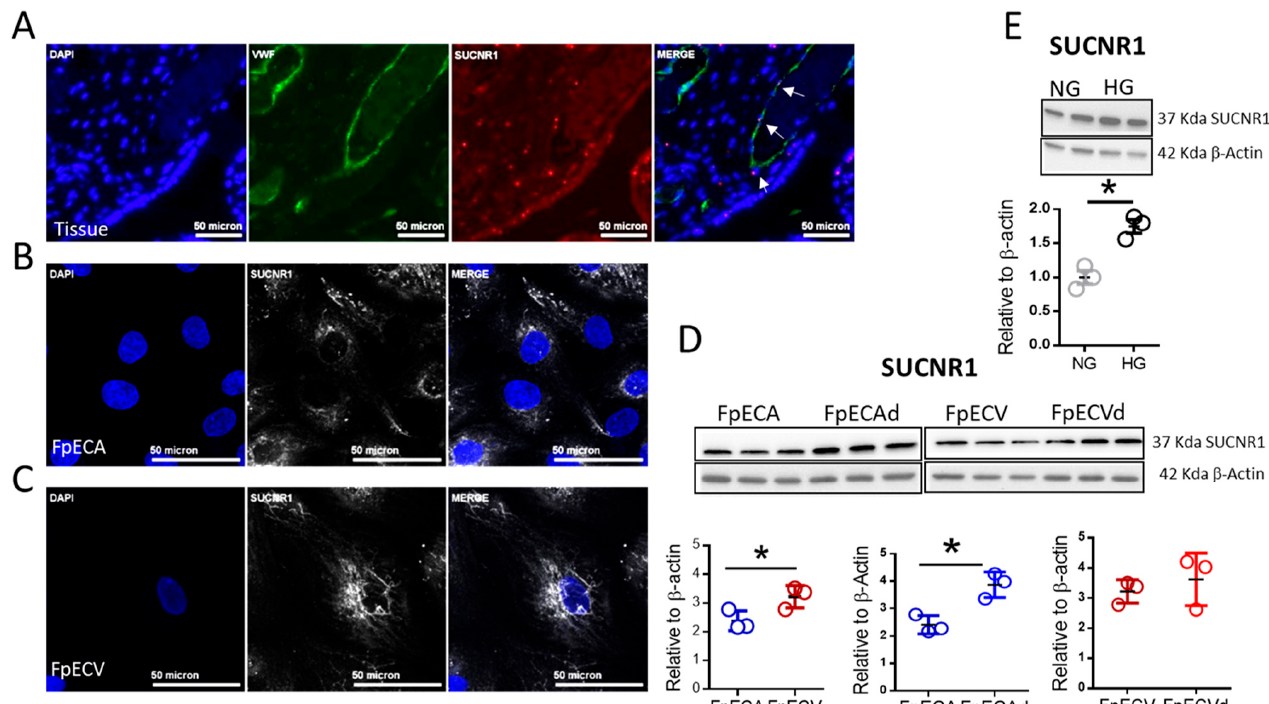
Figure 2. SUCNR1 expression in human full-term placental endothelial cells. ( A ) ISH combined with immunofluorescence staining of human full-term placenta. Tissue sections were stained with a probe against SUCNR1 and antibody against VWF as a marker for endothelial cells. Nuclei were counterstained with DAPI. Three sections from each placenta were examined and the shown image is representative for 5 normal placentas ( n = 5). White arrows show co-expression of SUCNR1 and VWF. ( B , C ) Immunofluorescence staining of FpECAs and FpECVs, respectively, using antibody against SUCNR1 and DAPI for counterstaining. Images are representative for 3 different isolations ( n = 3). ( D ) Western blot of SUCNR1 in isolated placental arterial and venous cells from GDM and normal pregnancies ( n = 3). ( E ) Western blot of SUCNR1 in primary HUVECs cultured in normal or high glucose for 48 h ( n = 3). For ( D ), unpaired t -test was used between groups, * p < 0.05, data are shown as mean ± SD ( n = 3). For ( E ), paired t-test was performed, * p < 0.05, data are shown mean ± SEM. Representative images and densitometry analysis are shown for ( D , E ).